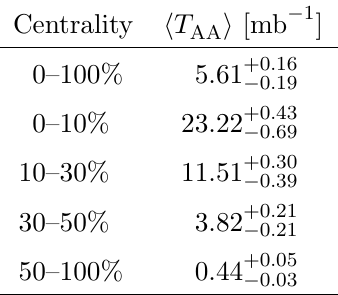
i ) and their uncertainties for AA